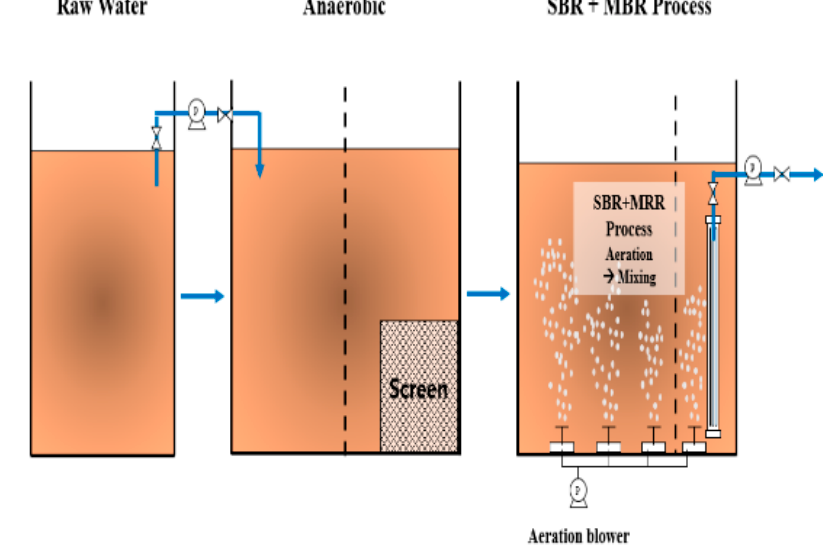
Figure 3. Schematic diagram of the Bench-scale shipboard STP.